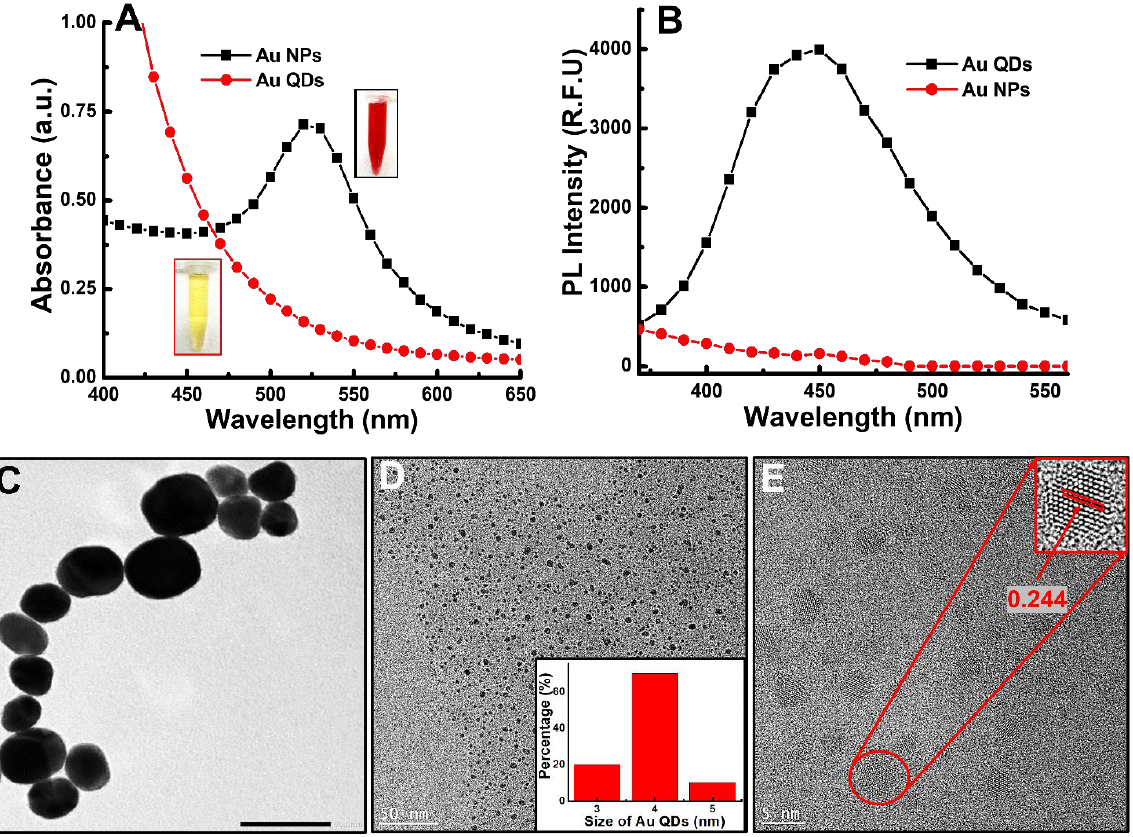
Figure 2. Identification of Au NPs and Au QDs: ( A ) absorbance of Au NPs and Au QDs; ( B ) fluorescence spectra of Au NPs and Au QDs; ( C ) TEM image of Au NPs: ( D ) HR-TEM image of Au QDs (inset: size distribution); ( E ) close view of Au QDs (inset: lattice fringes of Au QDs).